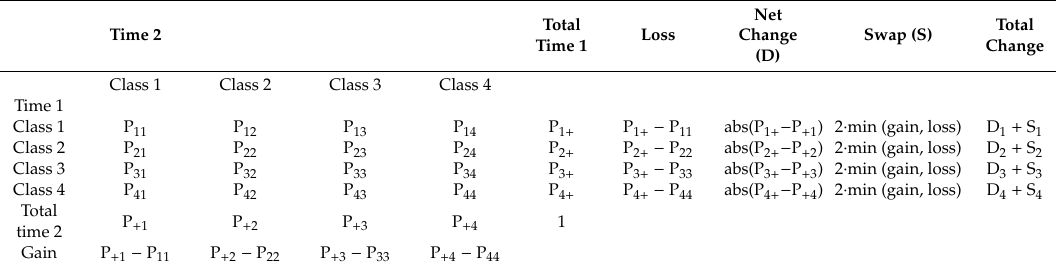
Table 1. The cross-tabulation table